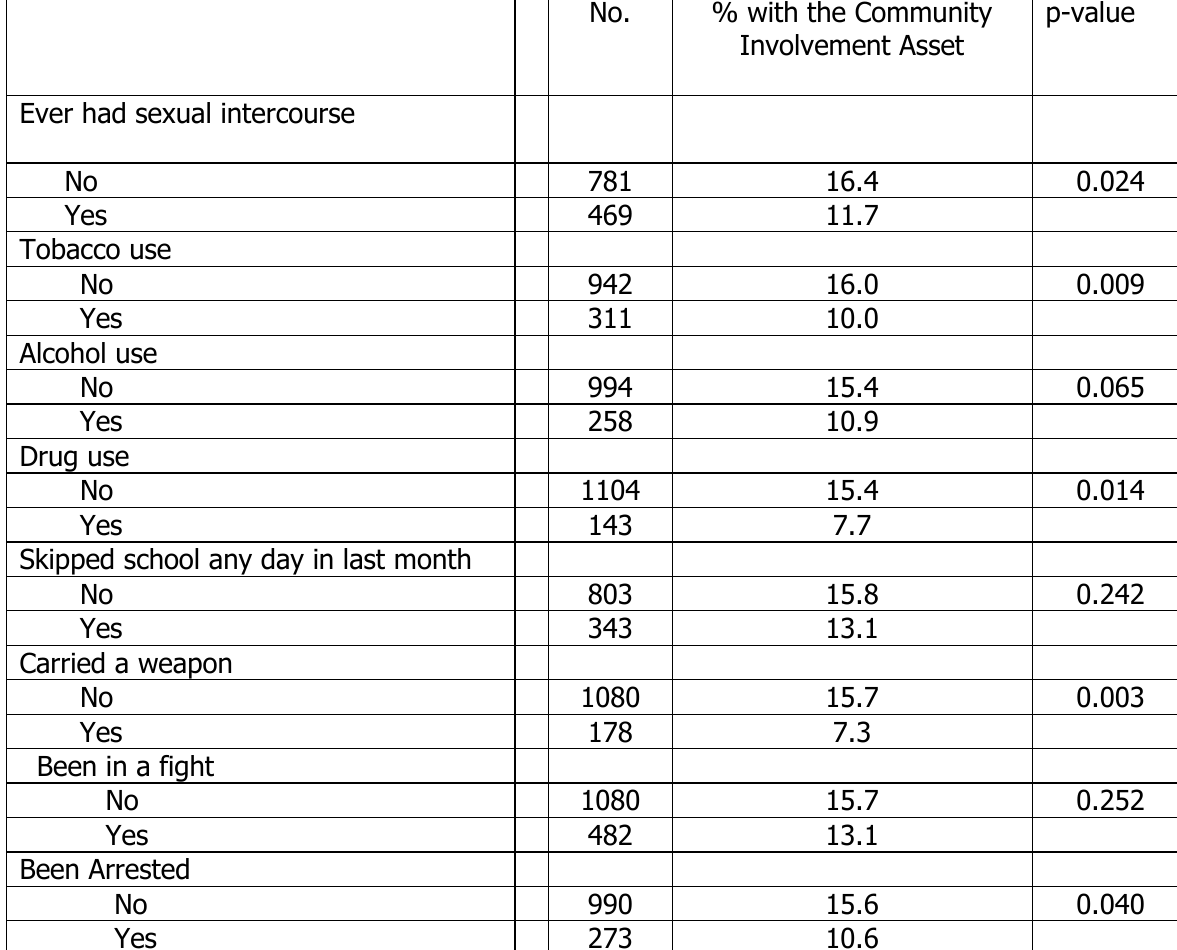
Frequencies and Chi-Square Values for Youth Risk Behavior and Community Involvement Asset No. % with the